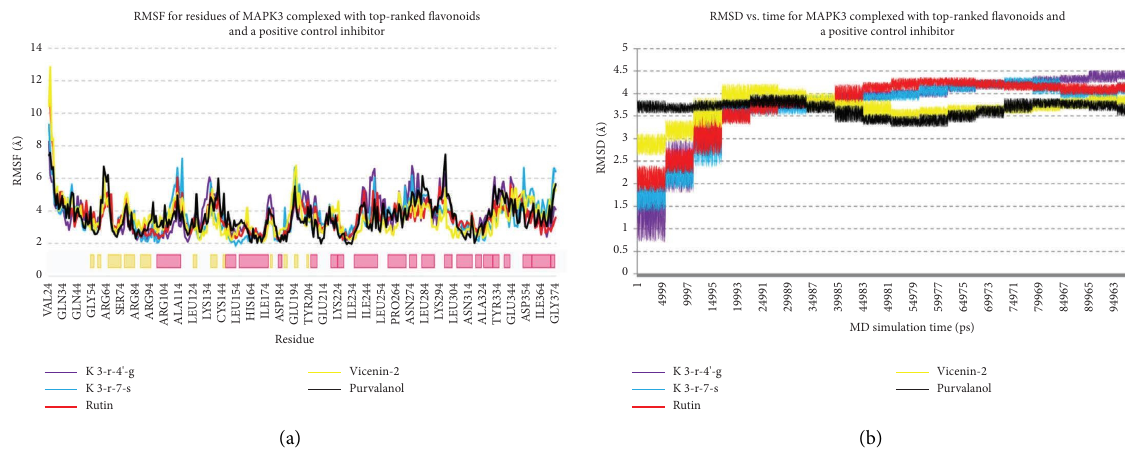
Figure 3: (a) RMSF and (b) RMSD for backbone atoms of MAPK3 complexed with top-ranked metabolites in this study and the standard drug. Te secondary structure of MAPK3 was obtained from the PDB database; yellow and pink colors show beta-strand and α -helix secondary structures, respectively. MAPK3, mitogen-activated protein kinase 3; RMSD, root-mean-square deviations; RMSF, root mean square fuctuation.